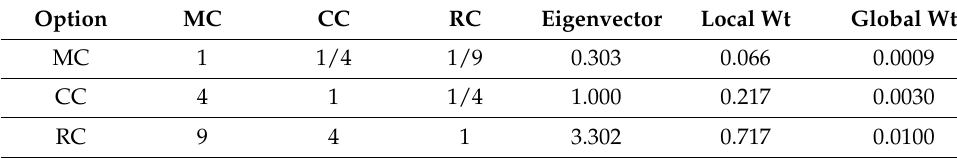
Table A14. Comparison of alternatives matrix for subcriterion PE1.